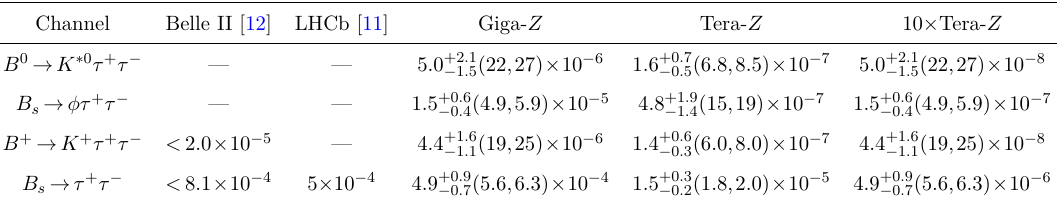
Table 10 . Expected precisions ( @1 σ C.L.) for the measurements of B 0 → K ∗ 0 τ + τ − , B s → φτ + τ − , B + → K + τ + τ − and B s → τ + τ − at Belle II, LHCb and the future Z factories. The superscripts